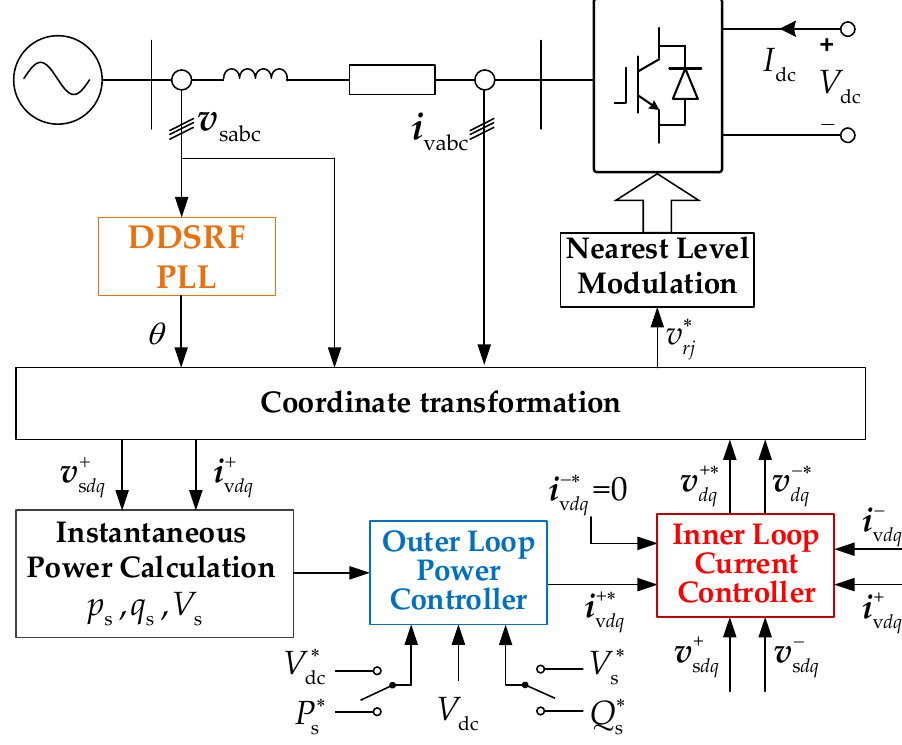
Figure 2. Control scheme of the MMC.